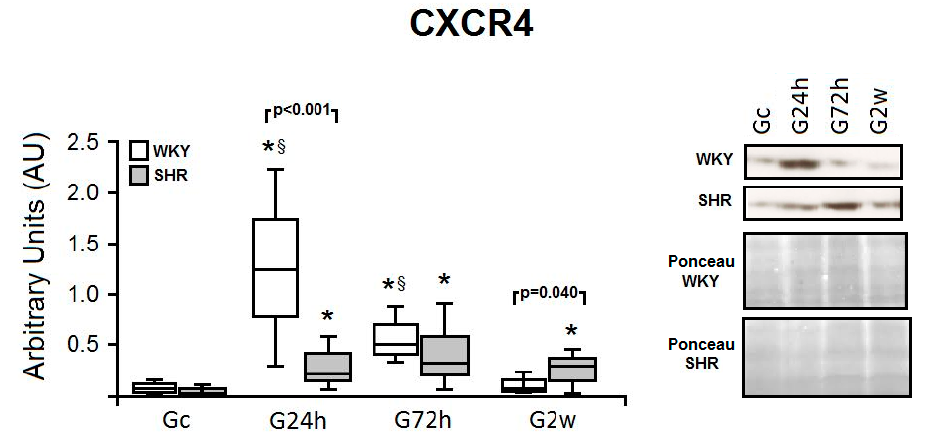
Figure 3. Cardiac tissue expression of CXCR4 in normotensive and hypertensive rats after daily supplementation with ω -3. Normotensive (WKY) and hypertensive (SHR) animals were submitted to CXCR-4 protein analysis in the heart tissue after 24 h, 72 h and 2 weeks of ω -3 supplementation and after 2 weeks of water intake. Data obtained by densitometry were compared to heart and animal weight, ponceau staining and are expressed in Arbitrary Units (AU). The right panel shows representative blots and reference bands (stained with Ponceau red) for all groups. The p values for comparisons between models at a specific time are shown in the figure. * p < 0.05 vs. Gc; § p < 0.05 vs. G2w. CXCR4, C-X-C chemokine receptor type 4; Gc, Control group; G24h, 24 h group; G72h, 72 h group; G2w, 2 weeks group